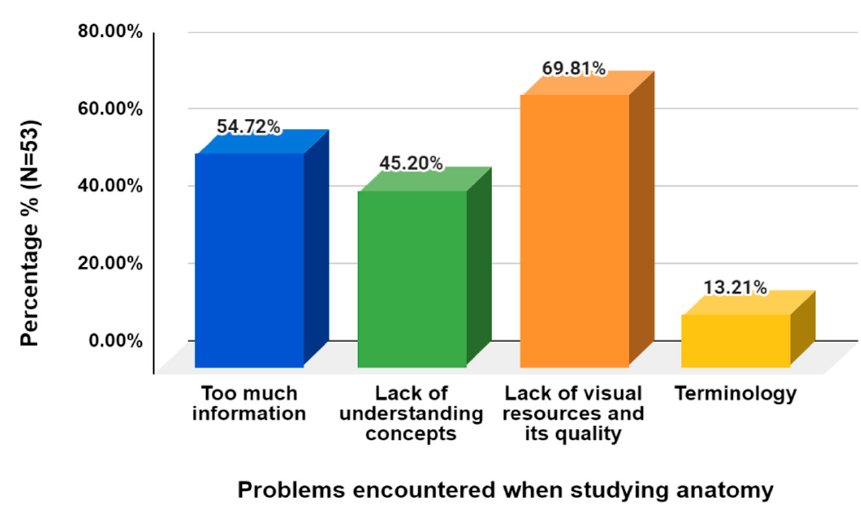
Figure 14. Problems that participants usually encountered when studying anatomy.